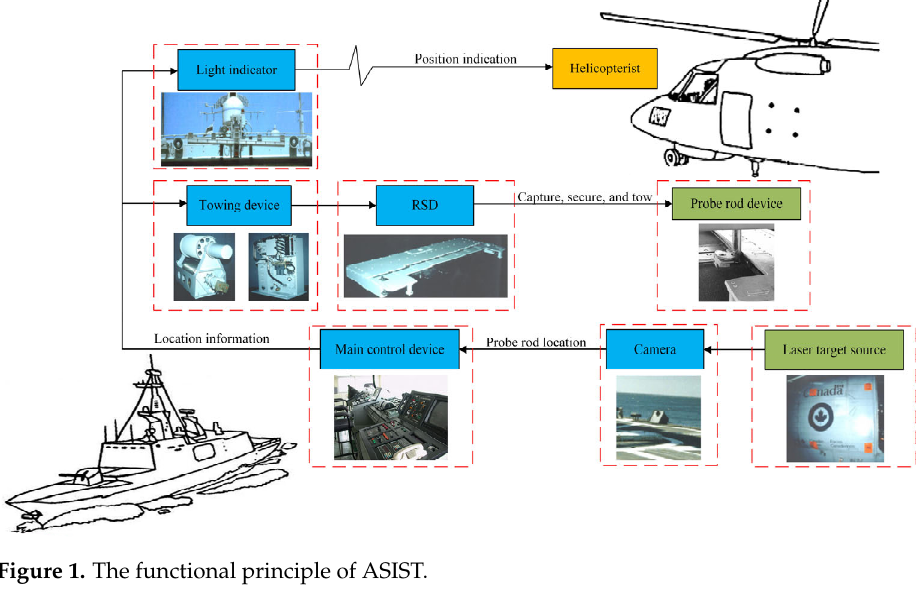
Figure 1. The functional principle of ASIST.